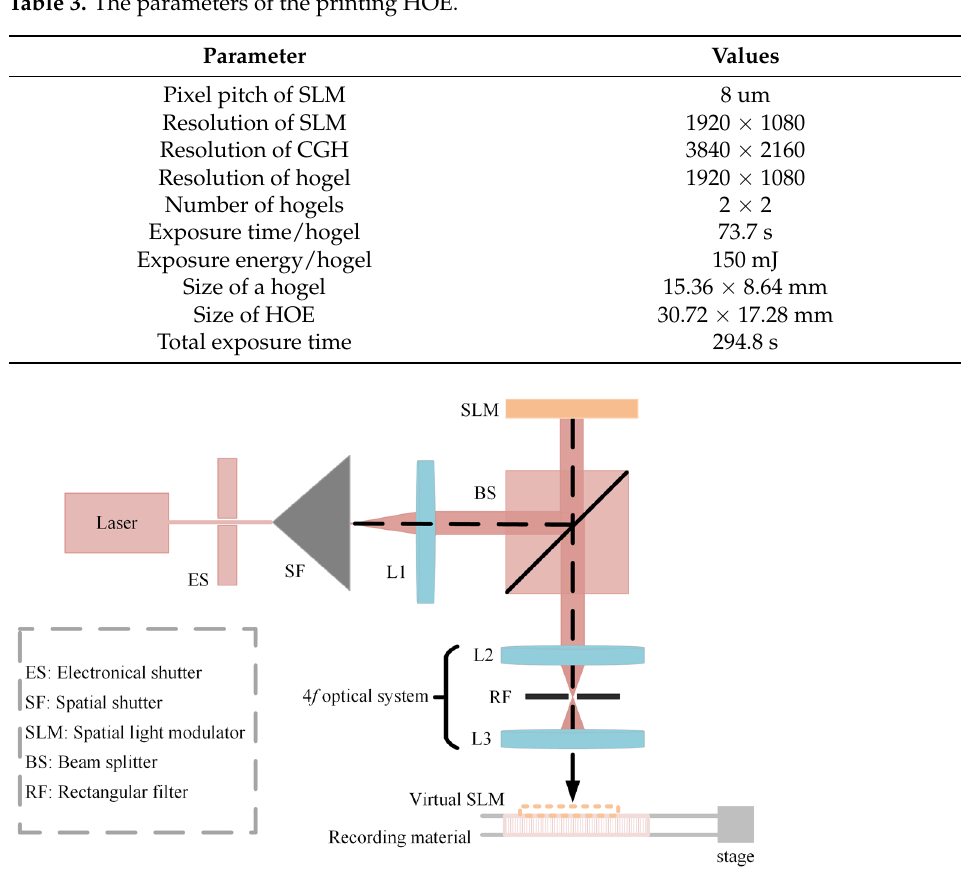
Figure 3. The setup for fabricating the